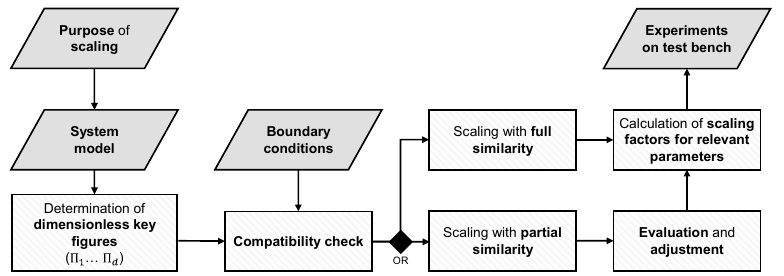
Figure 8. Procedure for deriving the scaling starting from a system model and considering the boundary conditions